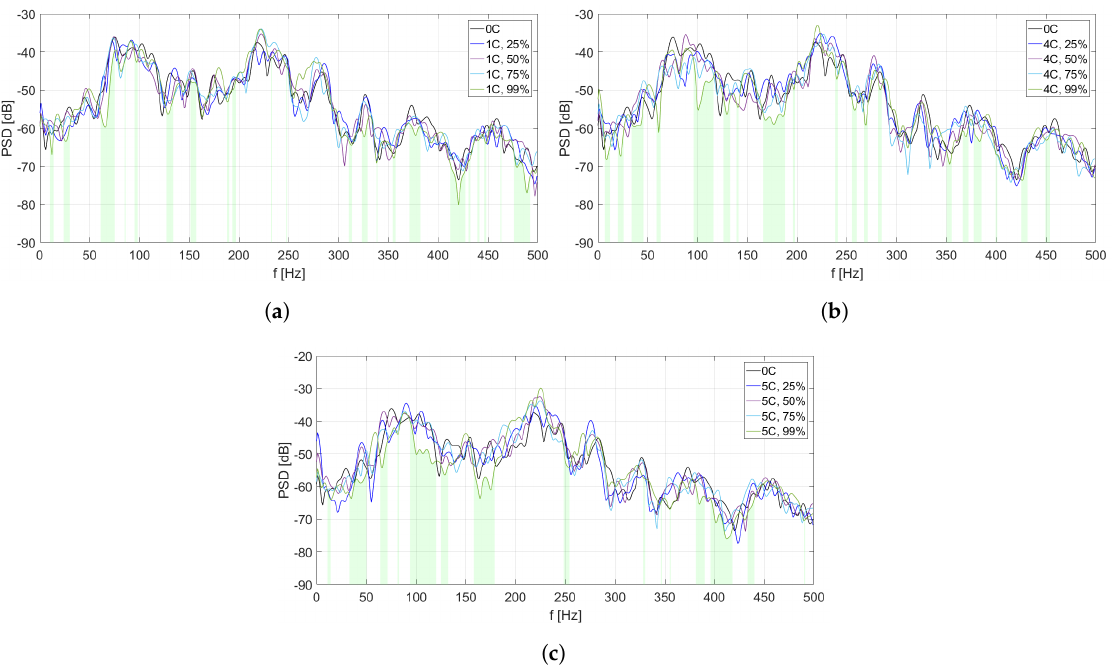
Figure 6. PSD estimates of MFC1 input signals: ( a ) scenario of one coupling activated, ( b ) scenario of four couplings activated, ( c ) scenario of five couplings